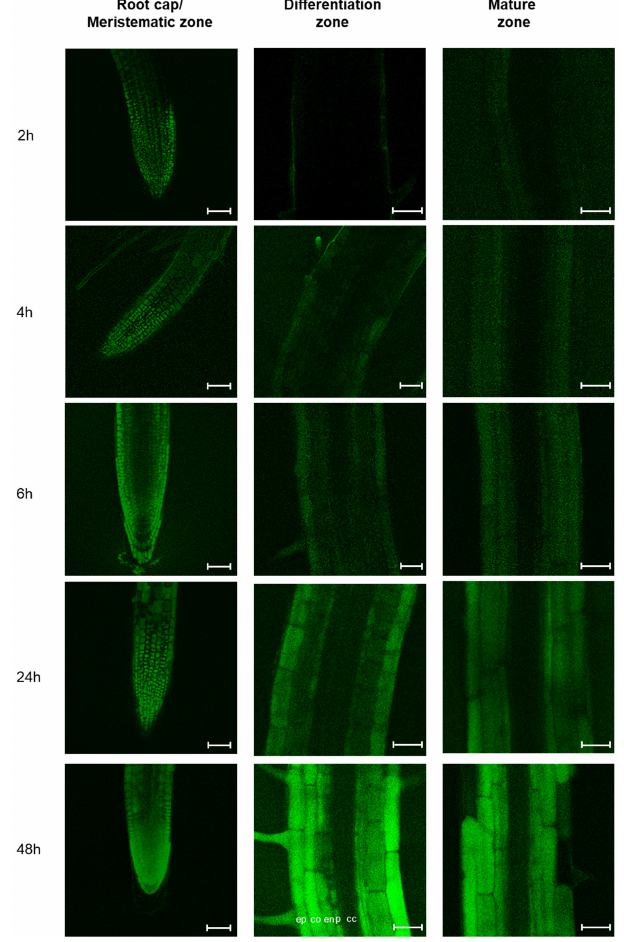
Figure 4. Kinetics of miPEP165a uptake into Arabidopsis roots. The mobility of miPEP165a-FAM was followed at the indicated time in different zones of Arabidopsis roots, as defined by [31]. Confocal images are representative of four independent experiments, with at least 6 seedlings for each condition. Bar = 50 µm (root cap/meristematic zone) or 25 µm (differentiation and mature zones). The different cell layers are indicated in the differentiation zone image at 48 h as follows: cc, central cylinder; p, pericycle; en, endodermis; co, cortex; ep, epidermis.